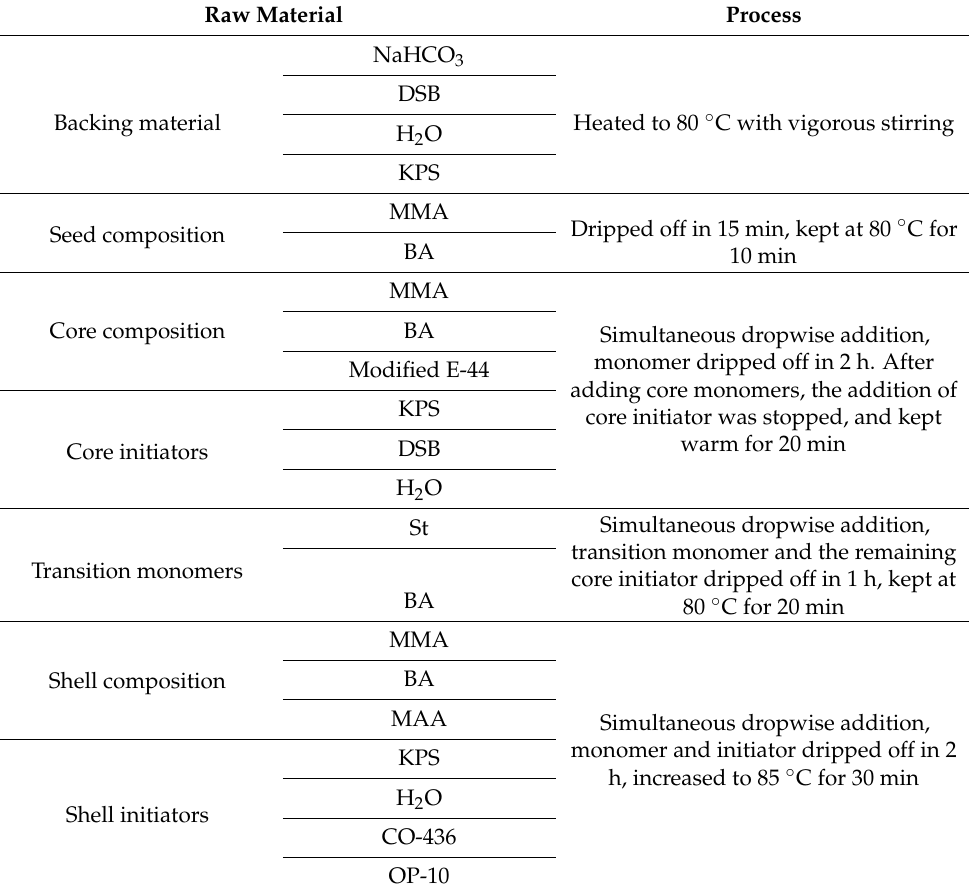
Table 1. Factors for the synthesis of three-layer core-shell-structured waterborne epoxy-styrene- acrylate composite